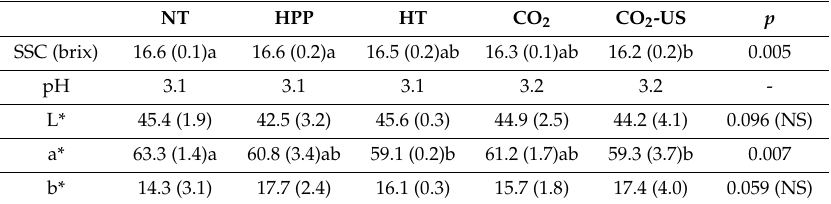
Table 2. Soluble solid content (SSC), pH, and color parameters of pomegranate juices (mean values and standard deviation) and ANOVA p -values ( p